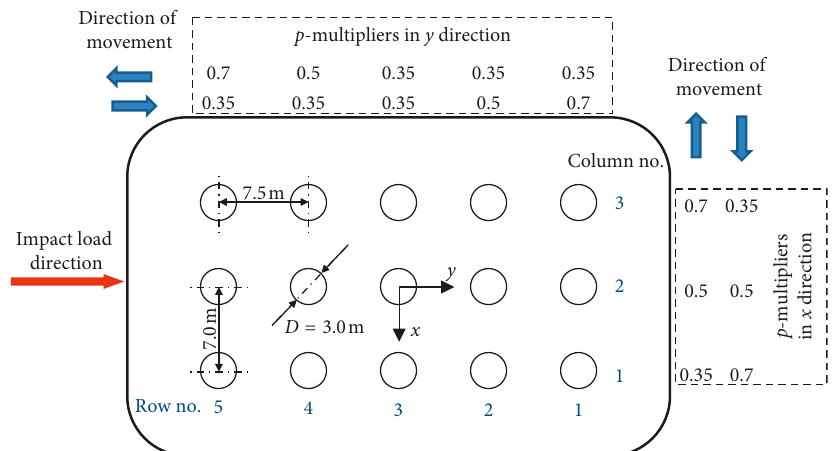
Figure 4: p -Multipliers in each row of the pile group.